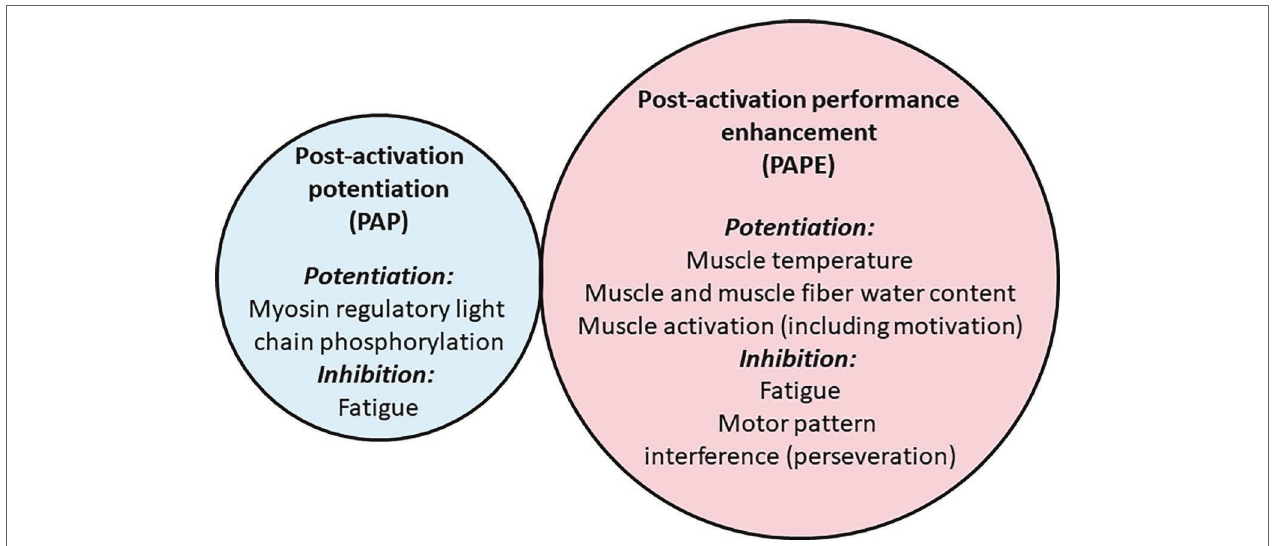
FIGURE 4 | Potential factors influencing post-activation potentiation (PAP) and post-activation performance enhancement (PAPE). The smaller and more transient PAP effect (left circle) is largely explained by myosin regulatory light chain phosphorylation (although other factors may play a small role), and may be briefly inhibited by factors associated with fatigue. The longer-lasting PAPE effect (right circle) may potentially be associated with increases in muscle temperature and muscle water, although enhancements in muscle activation (partly through motivation) may influence performance, while it may be inhibited for several minutes by residual fatigue or motor pattern interference (perseveration) effects. Thus, there may be minimal commonality of mechanism. However, while the mechanisms underpinning PAP are thought to be relatively well defined, there is a lack of evidence regarding the mechanisms that contribute to